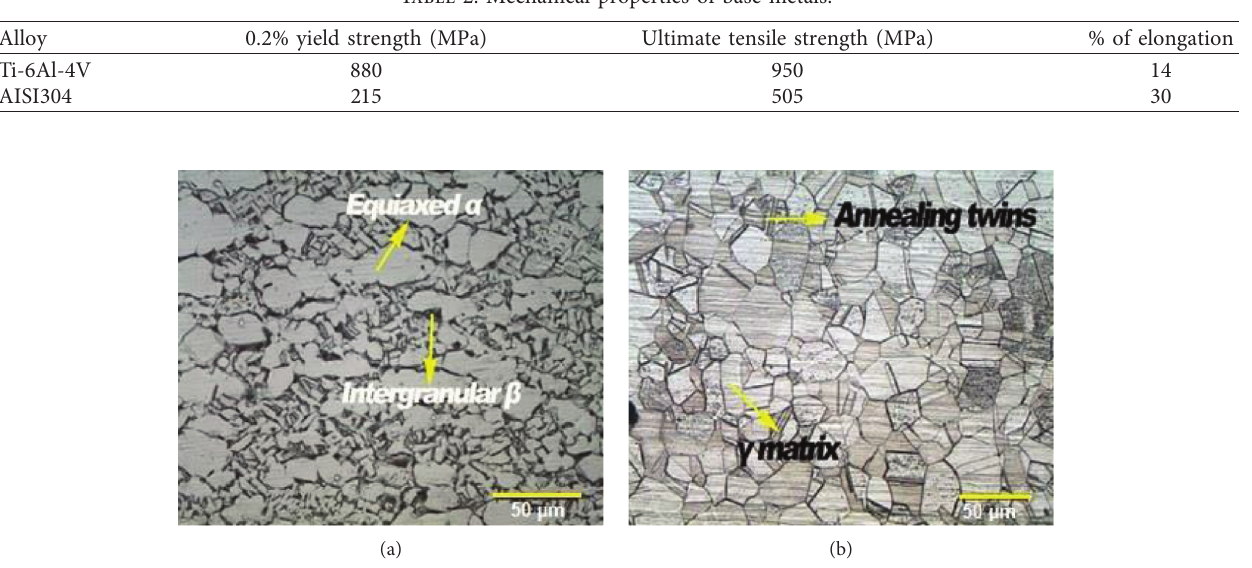
Figure 1: Optical micrographs of the base materials: (a) Ti-6Al-4V and (b) AISI304.